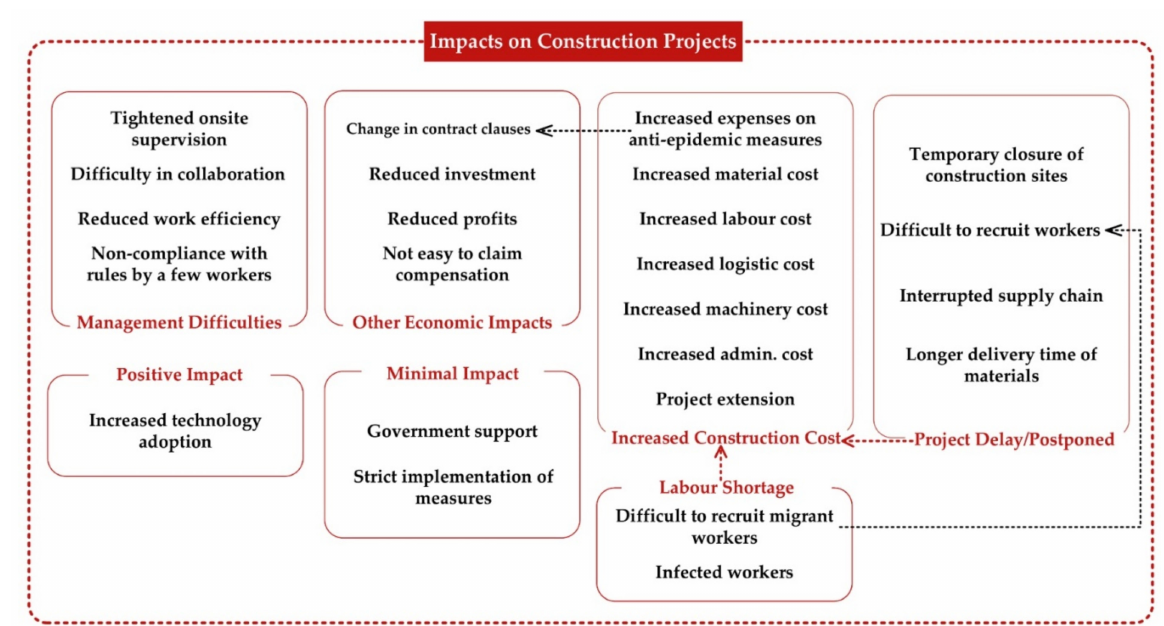
Figure 1. The impacts of COVID-19 on construction projects. Dotted line implies the potential causal relationship based on the interviewees’